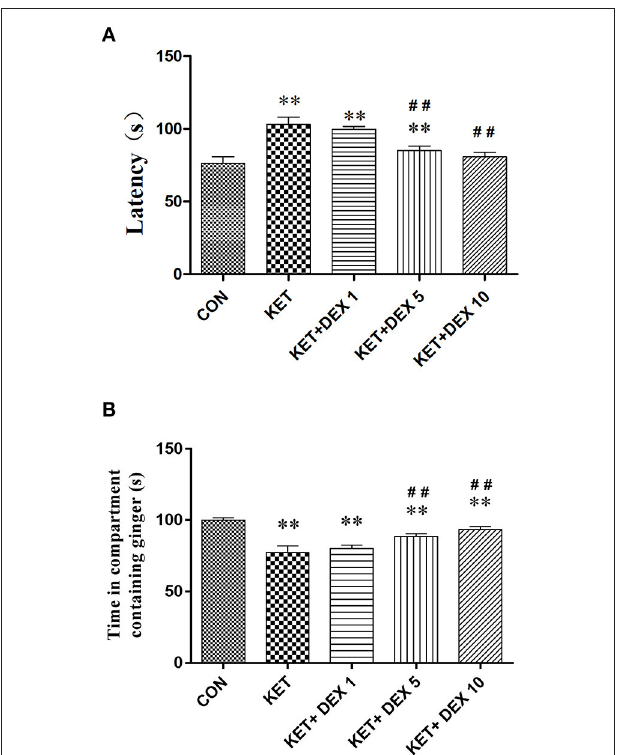
FIGURE 4 | The effects of ketamine and dexmedetomidine (DEX) exposure during development on performance on olfactory behavioral tests in the adult stage. The buried food test (A) . The latency to find the feed within 5min in the ketamine group was significantly longer than that in the control group. The longer latency to find hidden feed induced by ketamine was partially reversed by dexmedetomidine (DEX) in a dose-dependent manner. The olfactory memory test (B) . The time that rats stayed in the compartment containing ginger essential oil was significantly decreased in the ketamine group compared with the control group. The olfactory memory dysfunction induced by ketamine was partially reversed by dexmedetomidine (DEX) in a dose-dependent manner. The data are presented as the means ± SD ( n = 10 per group). ** p < 0.01 compared with the Control group; ## p < 0.01 compared with the KET